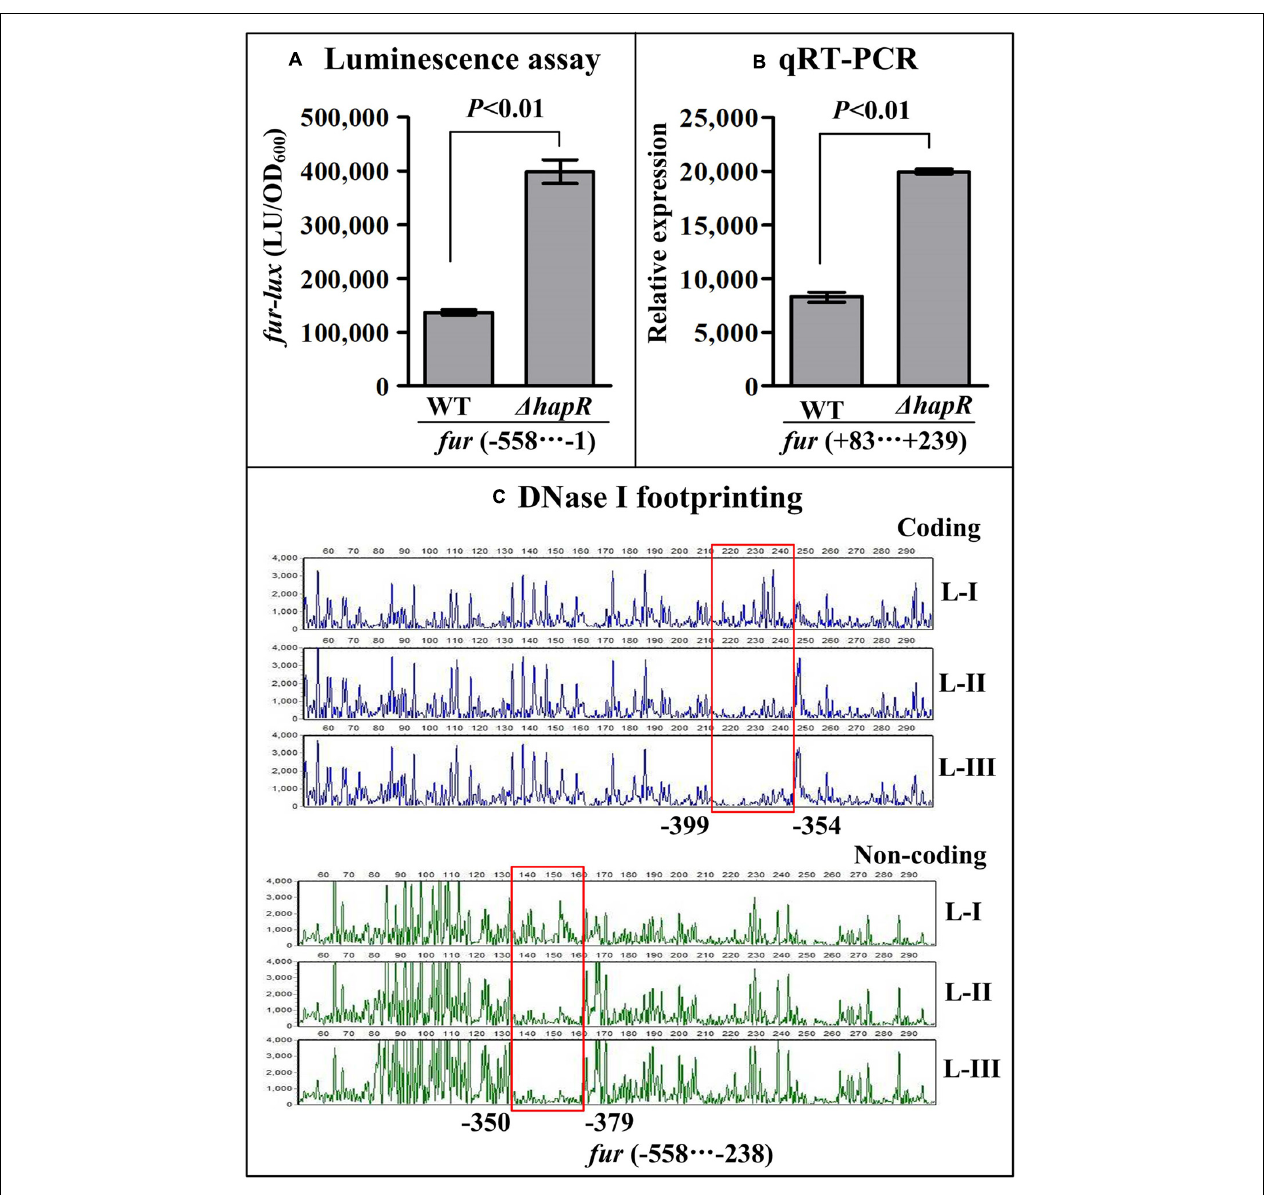
FIGURE 7 | Transcription of fur was negatively regulated by HapR. The luminescence assay (A) was done as Figure 2 . The qRT-PCR (B) and DNase I footprinting assay (C) were done as Figure 3 .